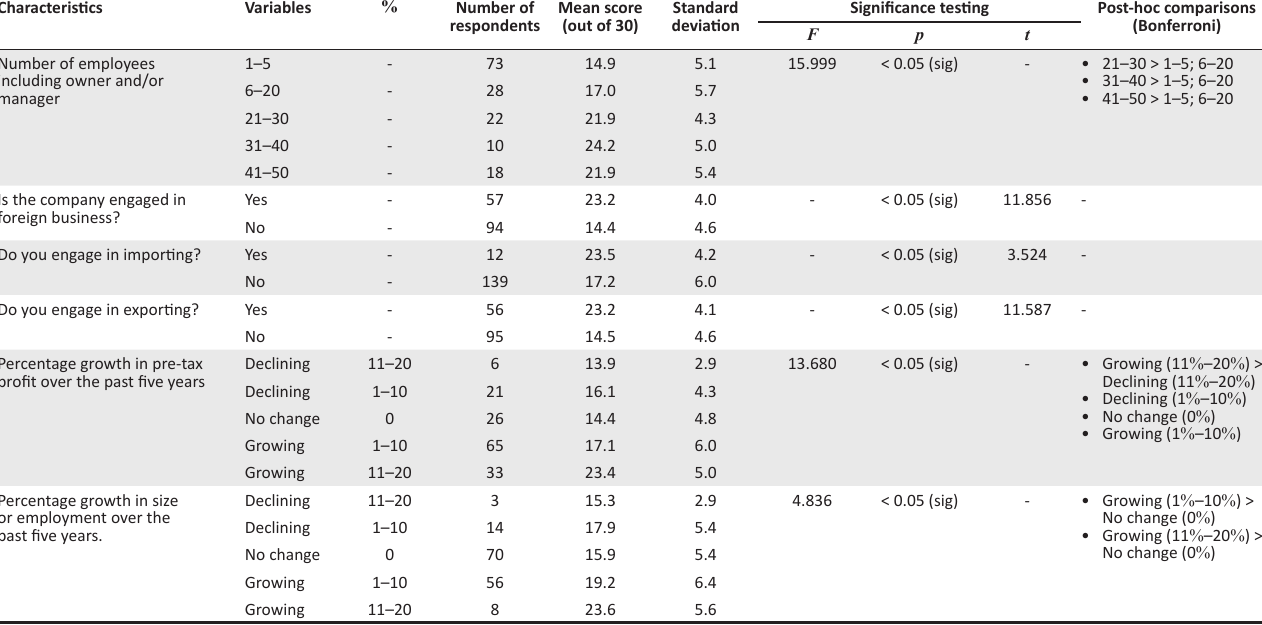
TABLE 3: Comparison of mean scores on the ‘importance or relevance of internationalisation’ index and business performance characteristics.